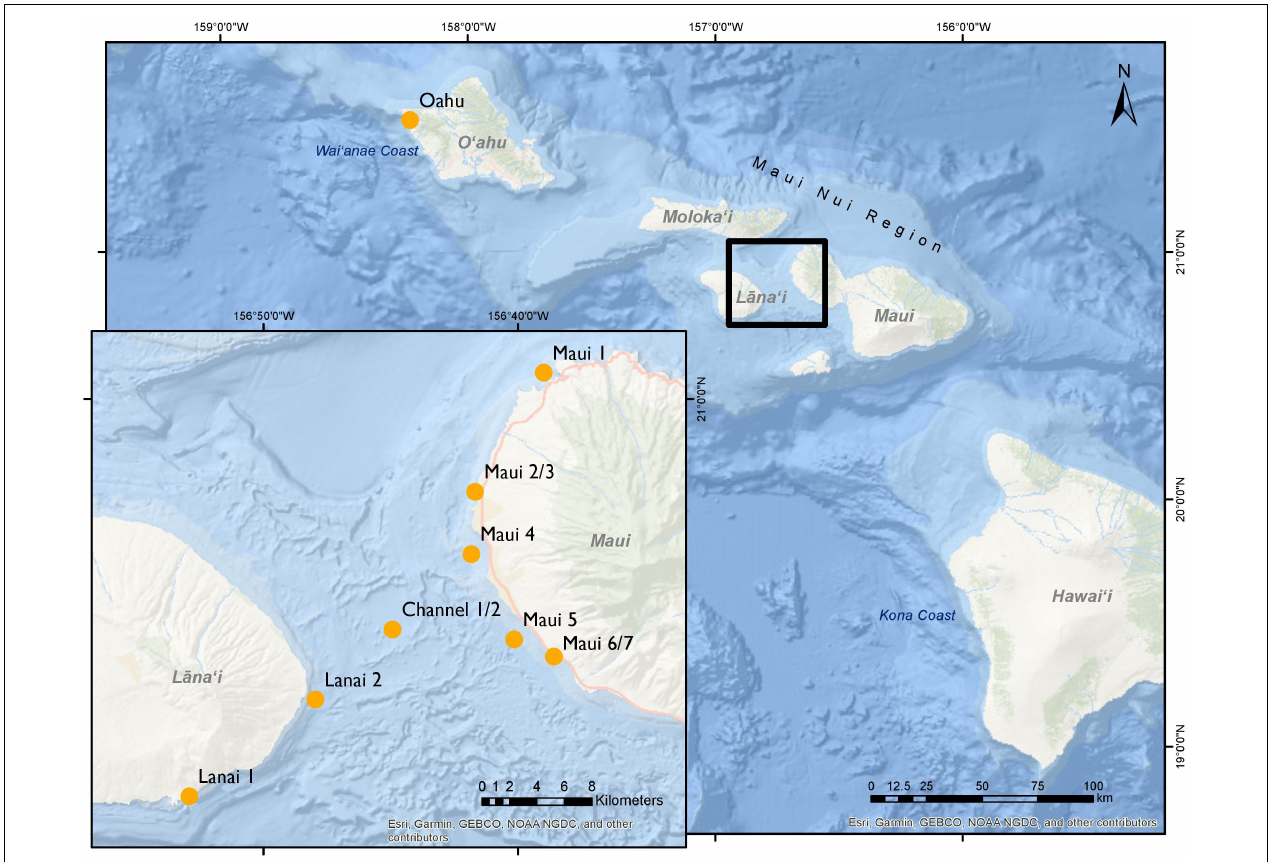
FIGURE 1 | Location of 2015 and 2016 Ecological Acoustic Recorders (EARs) used to monitor the acoustic presence of Hawaiian spinner dolphins at eight locations in Maui Nui (shown in the inset), and one location off the Wai‘anae Coast of O‘ahu.